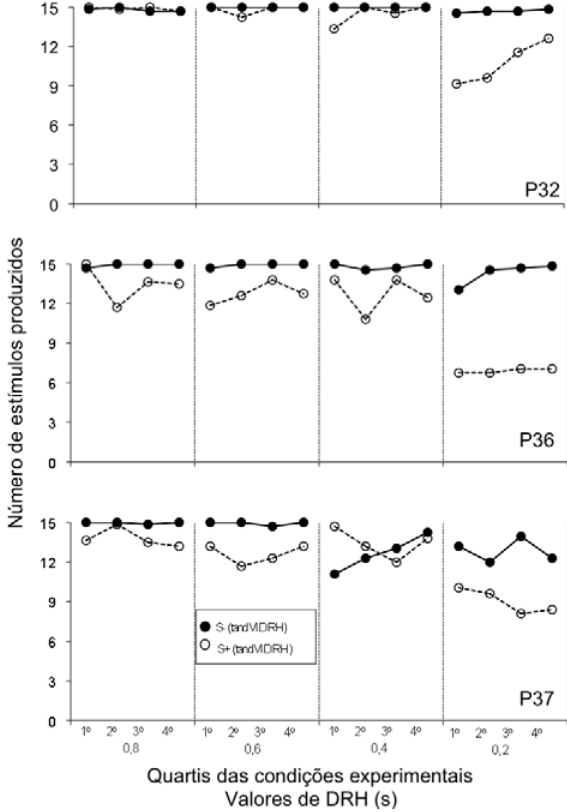
Figura 2 . Número médio de S + (círculos vazados) e de S - (círculos cheios) produzidos nas condições em que cada um destes estímu- los encontrava-se sob tand VI DRH 0,8 s, 0,6 s, 0,4 s e 0,2